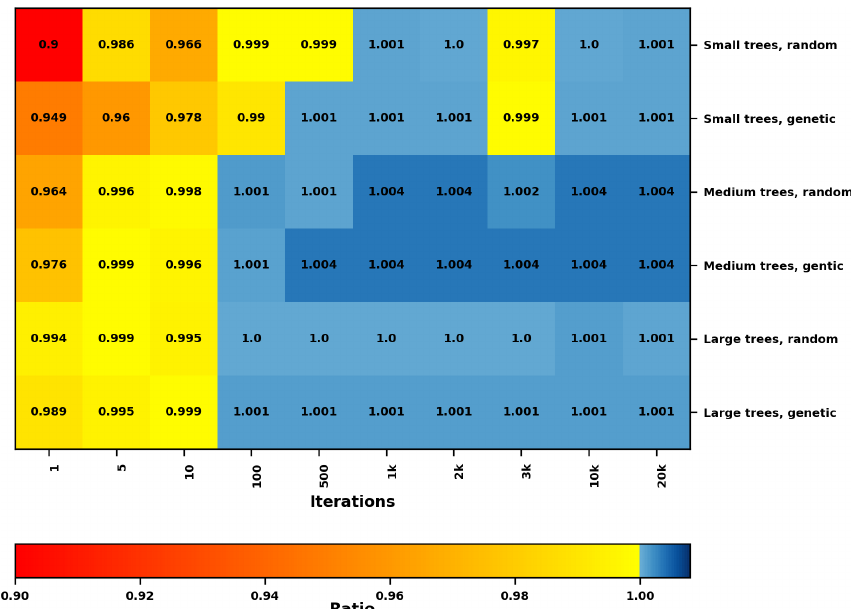
Figure 7. Heat map showing the ratio of potential decrease in T mrt between the hill-climbing algorithm and the greedy algorithm for the three different tree sizes (small, medium and large; see Table 1) for different numbers of model iterations, for 09:00–16:00LST on 22 June 1983. Two starting algorithms were used: random and genetic. Each model run was executed with five trees. There are 1709 potential locations for small trees, 1603 for medium trees and 1481 for large trees. A ratio > 1 indicates a larger T mrt decrease with the hill-climbing algorithm. Note the cell color where ratios ∼ 1 . 0 is determined using an extended number of decimal places.